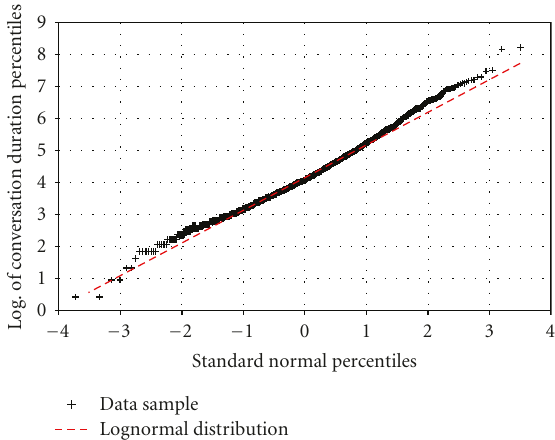
Figure 3: Probability plot for the logarithm of conversation dura- tion (for normally terminated calls) versus normal standard distri- bution.